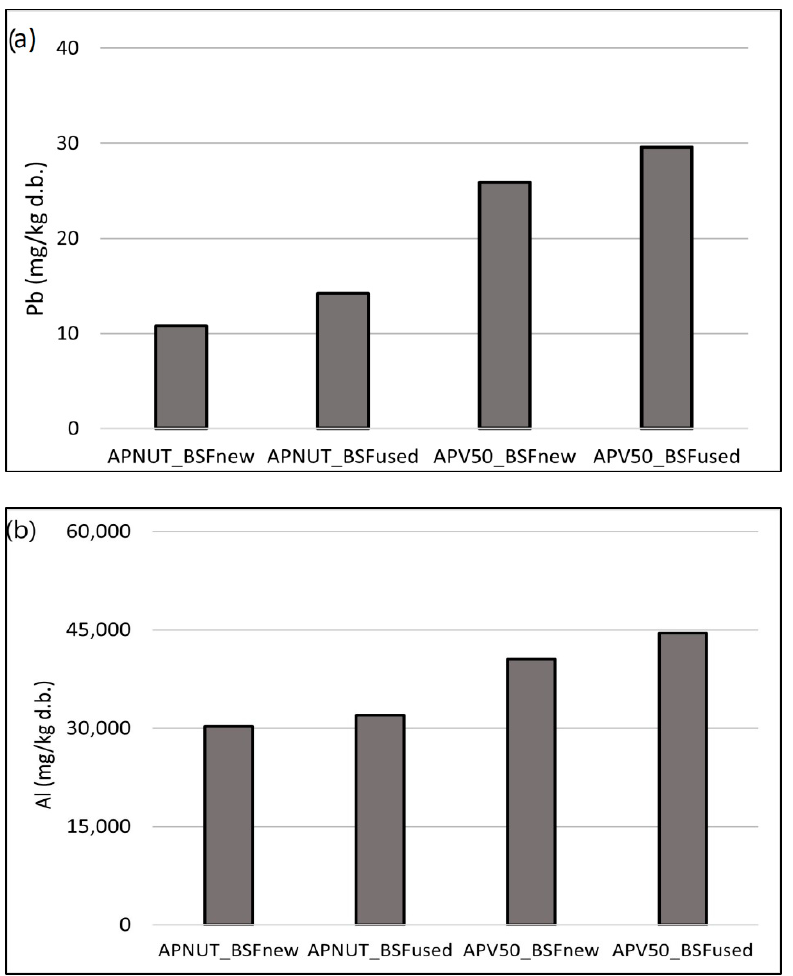
Figure 8. Pb ( a ) and Al ( b ) concentrations in the PIMs before (APNUT_BSFnew and APV50_BSFnew) and after (APNUT_BSFused, APV50_BSFused) their use as fertilizers in the soil. and after (APNUT_BSFused, APV50_BSFused) their use as fertilizers in the soil. Instrumental Instrumental uncertainty is equal to 20% of the values. uncertainty is equal to 20% of the